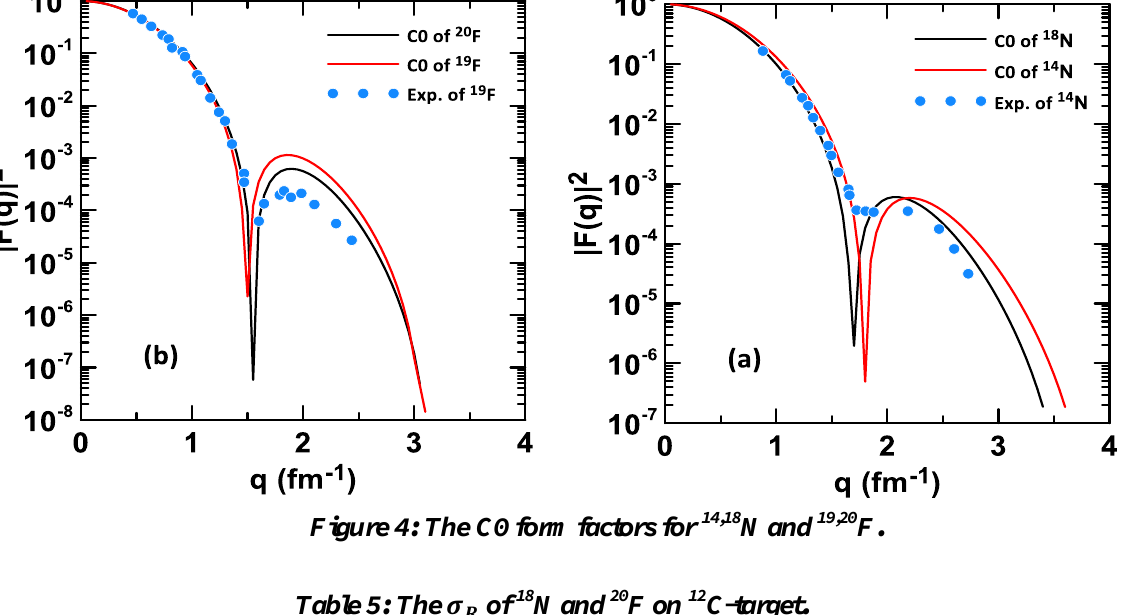
Figure 4: The C0 form factors for 14,18 N and 19,20 F. Table 5: The of 18 N and 20 F on 12 C-target.